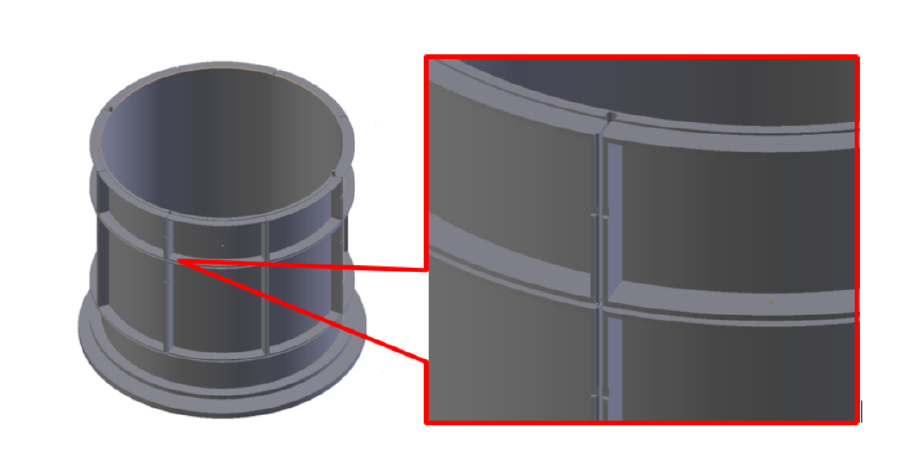
Figure 5. A concept of horizontal and vertical internal screening for 3D ECT sensor